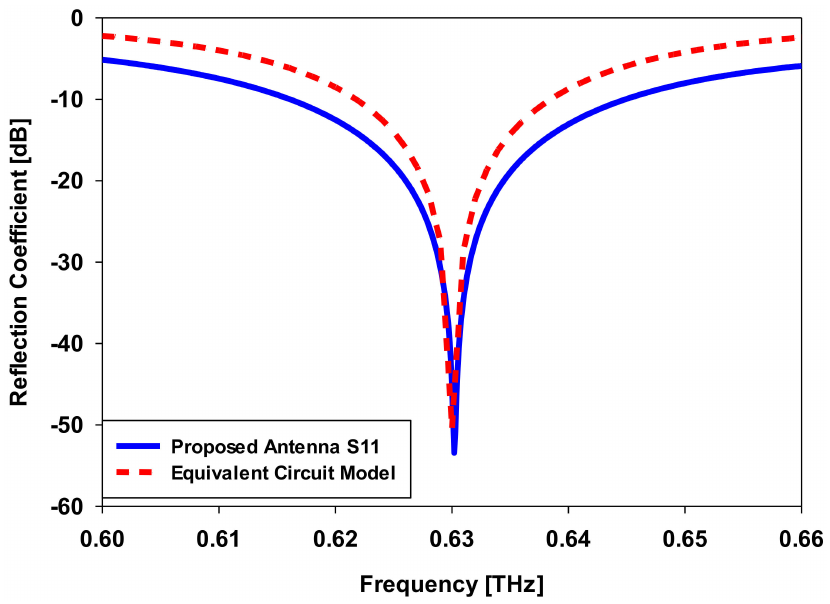
Figure 9. Comparison of reflection